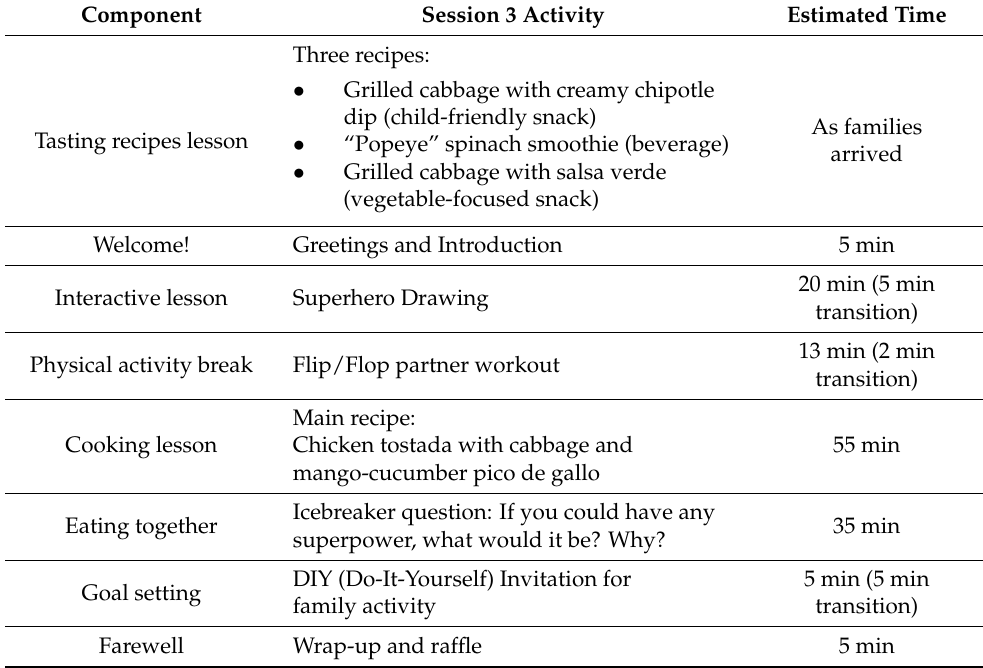
Table 2. Example of a week 3 “Cooking with Papi is Fun” with activities and estimated time.